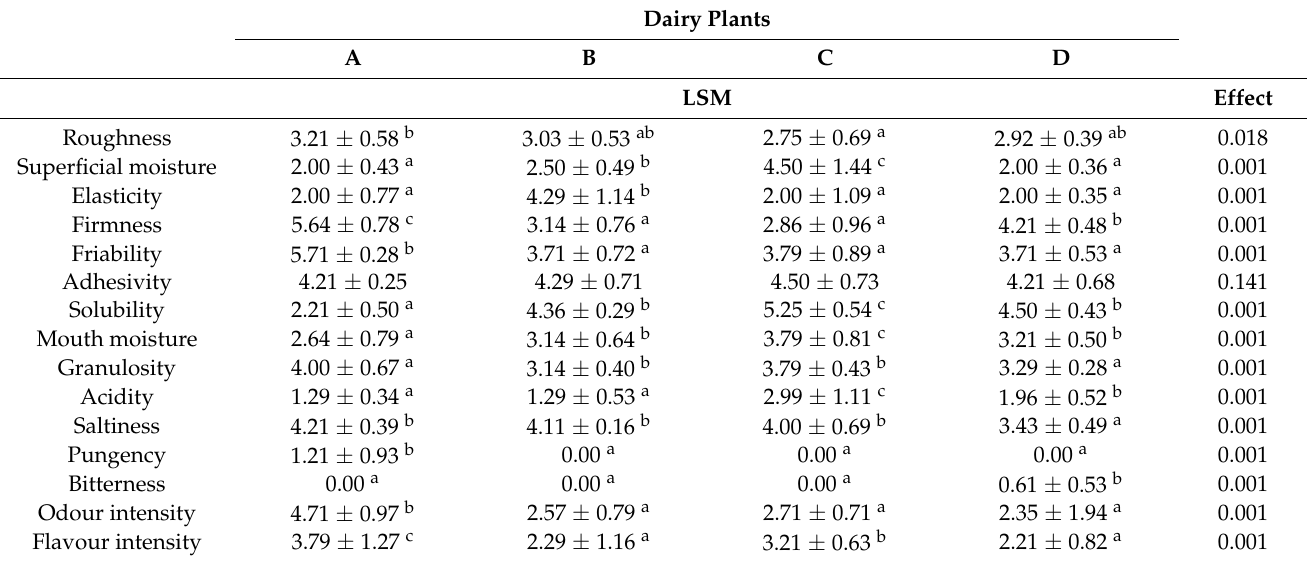
Table 6. Sensorial texture, odour and flavour characteristics of Palmero cheese (30 days) from 4 dairy plants. Dairy Plants A B C LSM